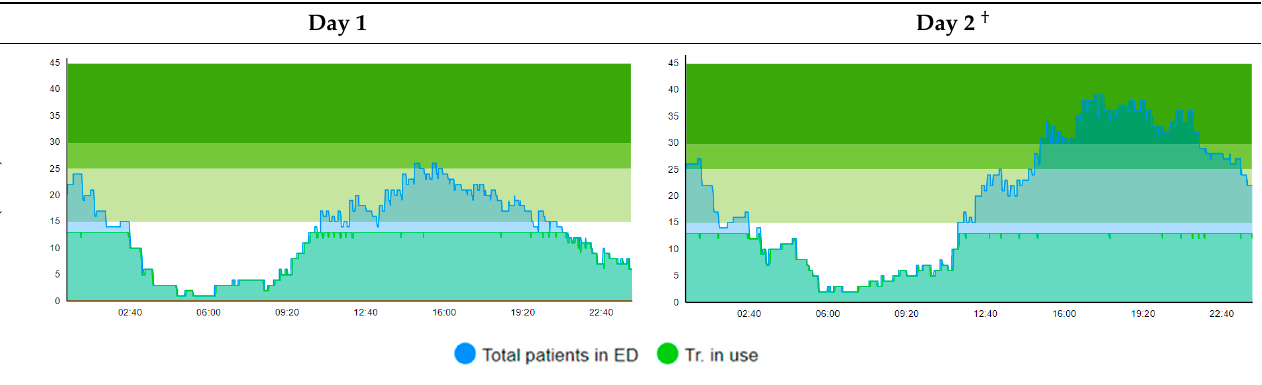
Table 6. Simulation output crowding graphs for Sc.1.